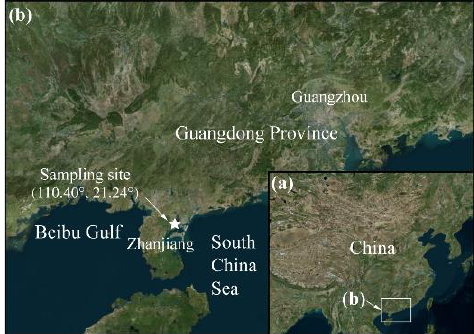
Figure 1. Sampling site of Zhanjiang clay: ( a ) location of Zhanjiang; ( b ) location of sampling site.